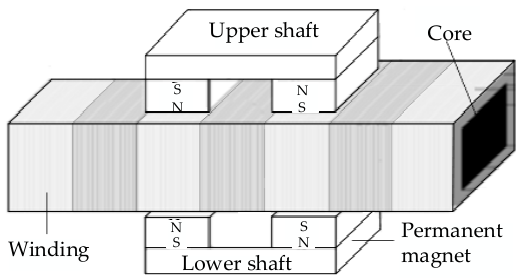
Figure 1. Structure of double-sided DC linear motor [1].